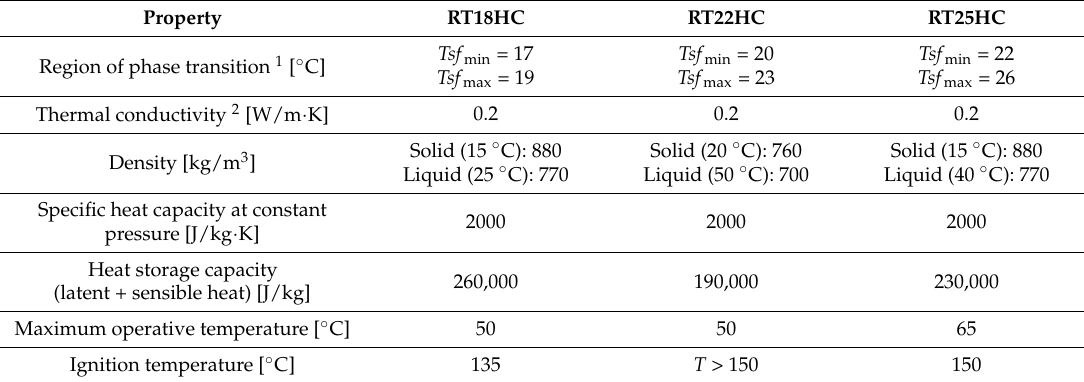
Table 3. Thermophysical properties of the RT18HC, RT22HC, and RT25HC PCMs